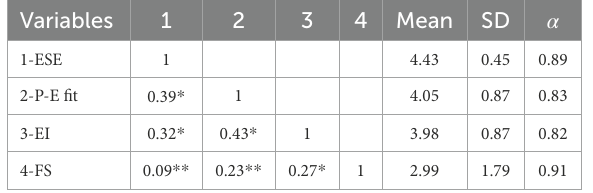
TABLE 1 Correlation and reliability